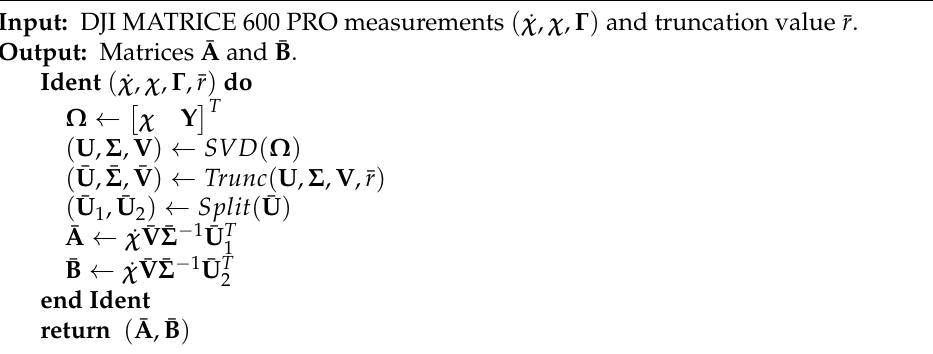
Algorithm 1 Identification process Using DMD